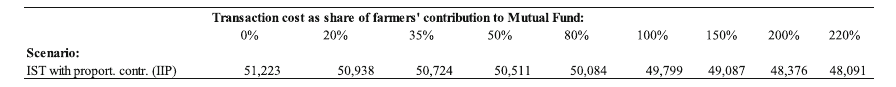
Table 10 Average annual farm income levels in the whole 2012 – 2015 period with application of growing levels of transaction costs. Farmers contribution to the mutual fund proportional to their